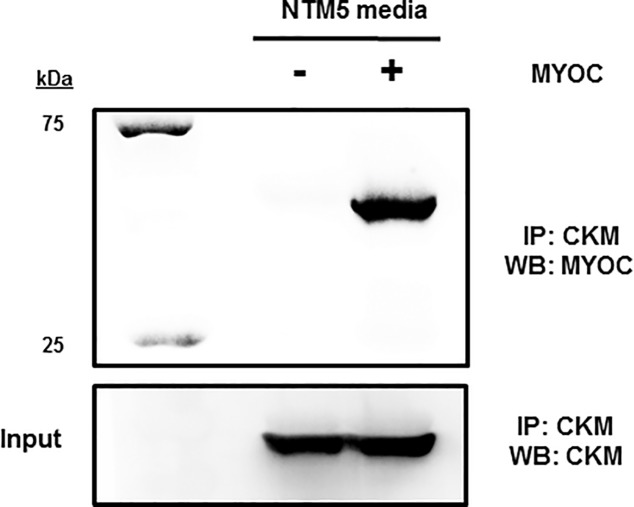
Western blot following immunoprecipitation (IP) indicates that CKM binds MYOC.The Western blot was stripped and treated with anti-CKM to show CKM input.